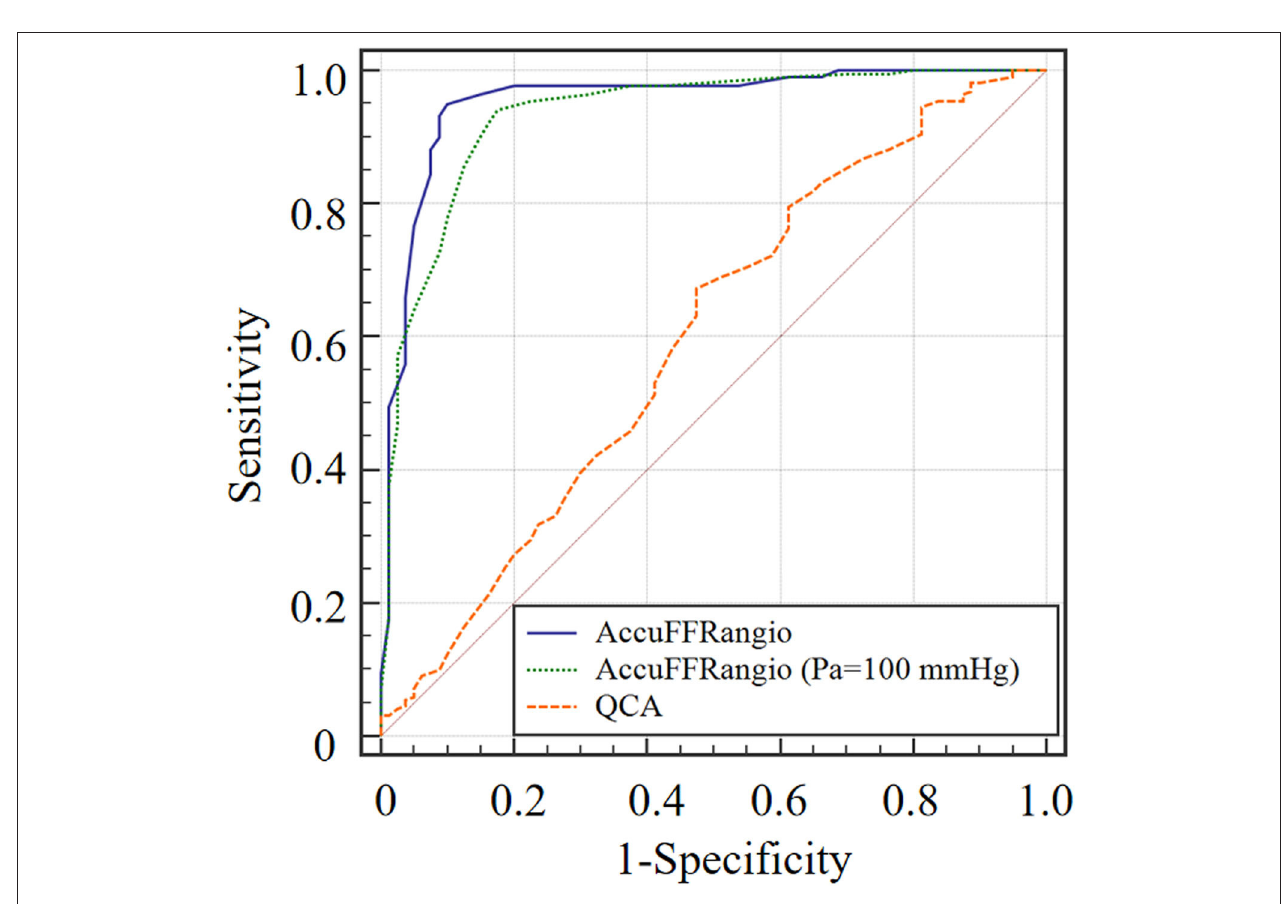
FIGURE 6 | ROC Curve between AccuFFRangio and